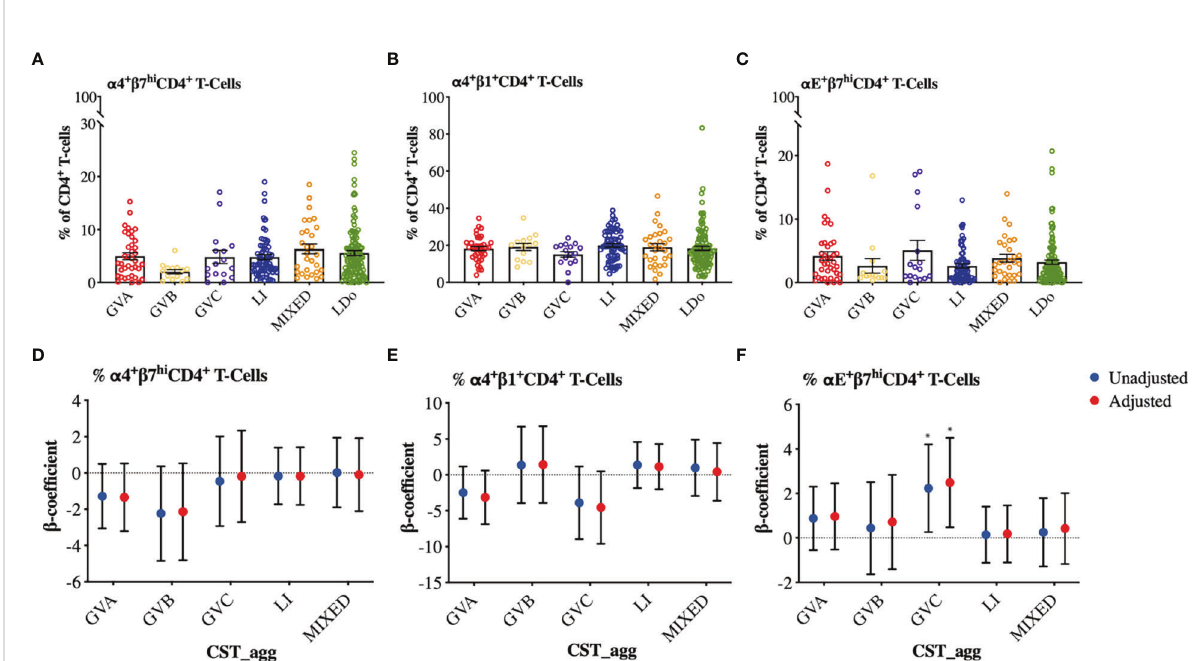
FIGURE 8 Comparison of integrin expression patterns among different cervicovaginal microbial groupings. Raw relative frequencies of (A) a 4 + b 7 hi (B) a 4 + b 1 + (C) a E + b 7 hi cells expressed as percent of total CD4 + T-cells shown per CST_agg. Linear mixed model analysis examining the association between cervicovaginal microbial groupings and (D) a 4 + b 7 hi (E) a 4 + b 1 + (F) a E + b 7 hi expressed as percent of total CD4 + T-cells. b - coef fi cients represent the mean change in relative frequency of a speci fi c cellular marker that is associated with a speci fi c microbiome structure (CST_agg) compared to Lactobacillus (non_iners) dominant microbial communities. Blue symbols represent unadjusted models only utilizing microbial groupings as predictors. Red symbols represent models following multivariable adjustment for hormonal contraceptive type, HSV-2 seropositivity at baseline, concomitant vulvovaginal candidiasis, age, use of BV antibiotics, use of other antibiotics, and use of antifungals prior to sample collection. The error bars in the raw cell count panels represent the standard error of the mean. The error bars from the linear mixed models represent the 95% con fi dence intervals associated with the estimates from the linear mixed models. *P ≤